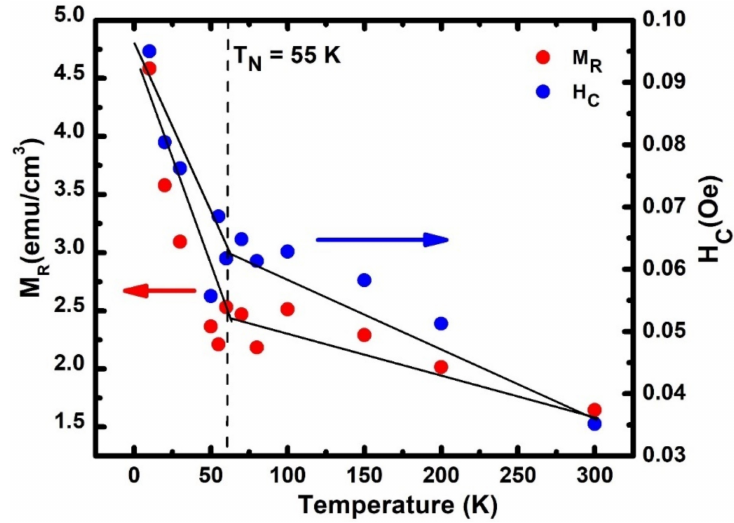
Figure 6. Temperature dependencies of remanent magnetization (M R ) and coercive field (H C ) of hysteresis curves of V 2 O 3 thin films.